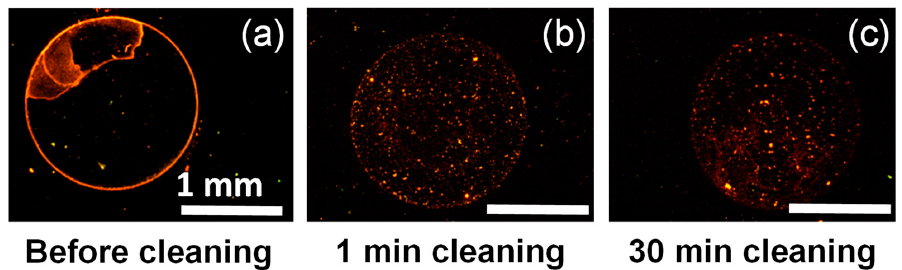
Figure 3. Epifluorescence microscopy pictures of a stainless-steel plate contaminated by spores and stained with acridine orange: ( a ) before cleaning by foam flow, ( b ) after one minute of foam flow cleaning based on DG, and ( c ) after 30 min of foam flow cleaning based on DG. The scale bar represents 1 mm for all the pictures.